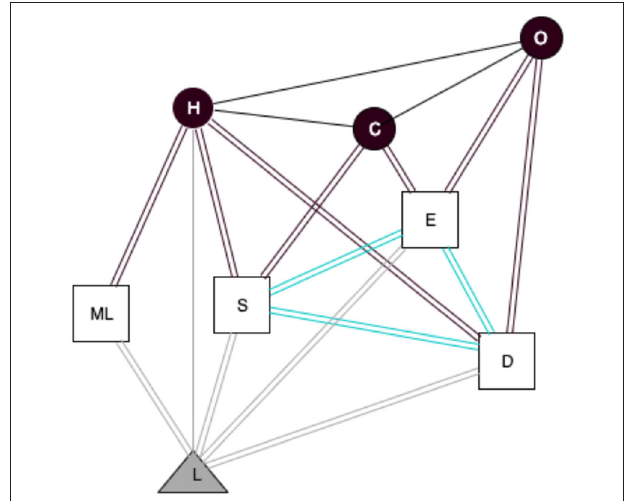
FIGURE 5 | Socio-material network on Jeac’s observation. Circle, actors (J, Jeac; P, Pietro); Triangle, analog objects (L, Laptop; Ds, Documents; N, Notebook); Squares, digital objects (C ++ , C ++ Software; E, Email); Black lines, social ties; Gray lines, usage of analog objects; Black double lines, usage of digital objects; Gray double lines, analog/digital